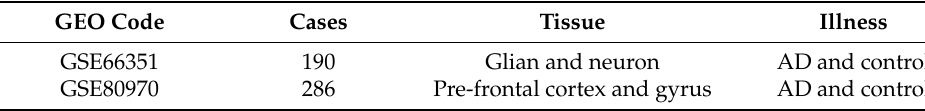
Table 1. Methylation data sets included in the analysis.